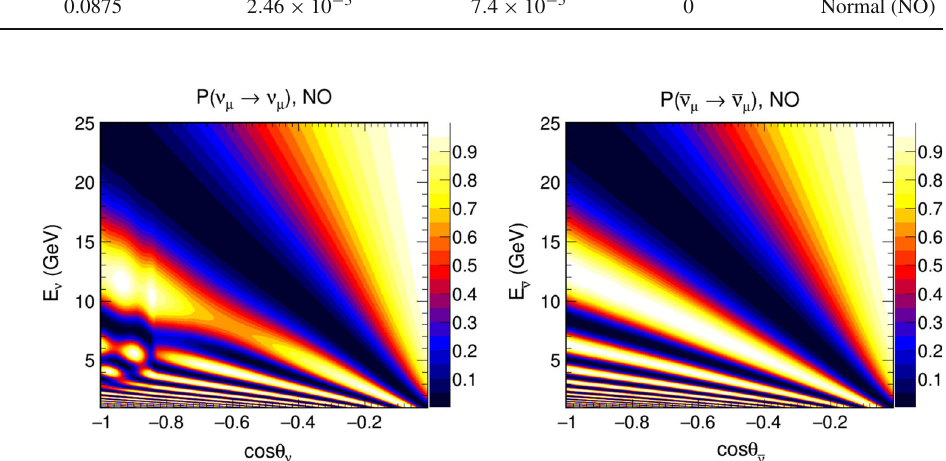
NO. Since matter effects on antineutrinos are not significant in NO, the ¯ ν μ survival probability does not show this